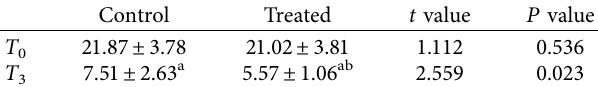
Table 4: The use of opioids between two groups of patients.